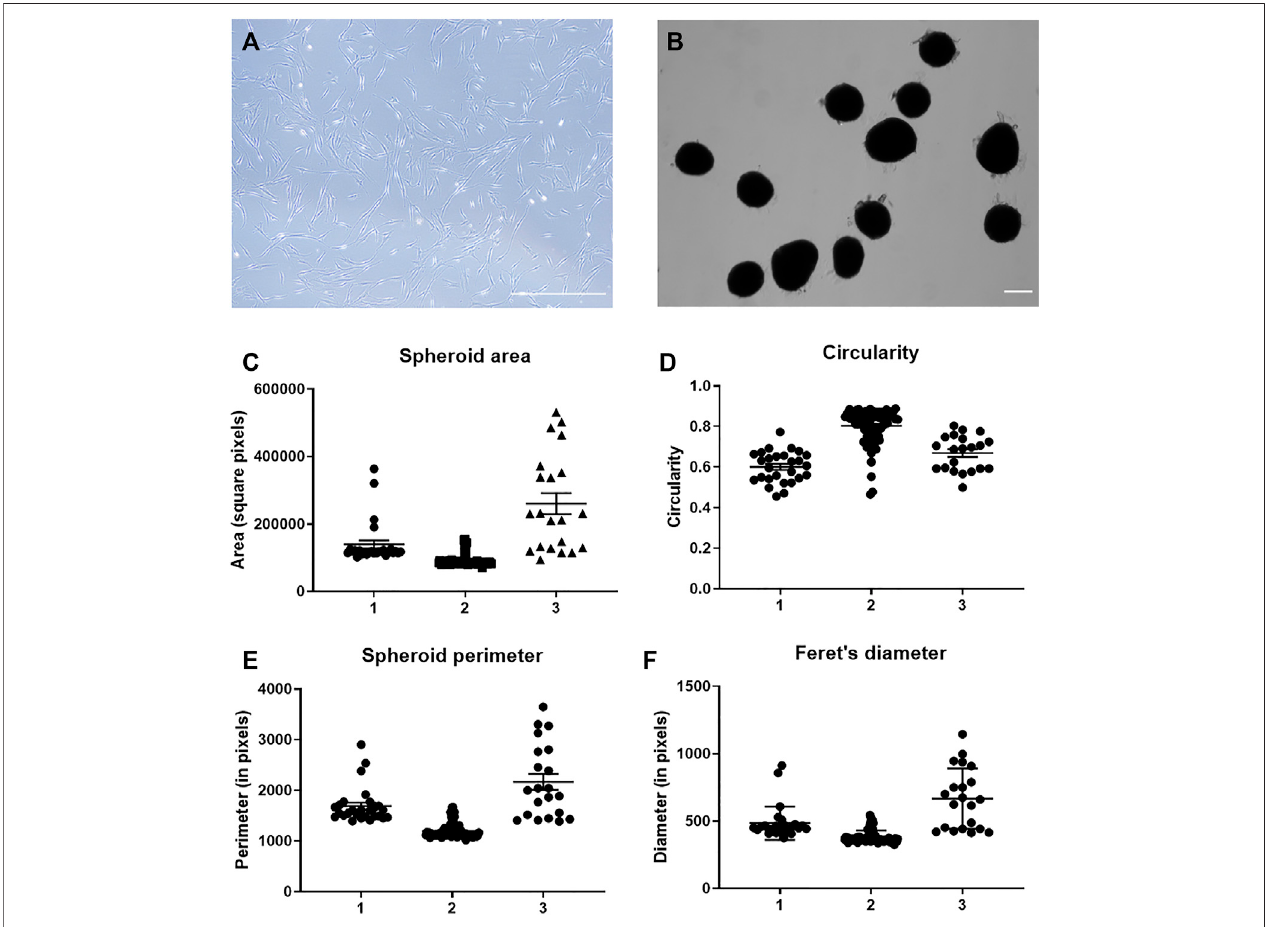
FIGURE 1 | Characterization of MSC spheroids. (A) Representative photomicrograph of MSC in 2D culture on tissue culture plastic and (B) MSC in 3D spheroid culture at day 4 of culture. Scale bar = 250 µm. Quantitation of (C) spheroid area, (D) spheroid circularity scales from 0 – 1 where a value of 1 represents a perfect circle, (E) spheroid perimeter and (F) Feret ’ s diameter performed at day 4 of culture with n = 3 MSC donors.